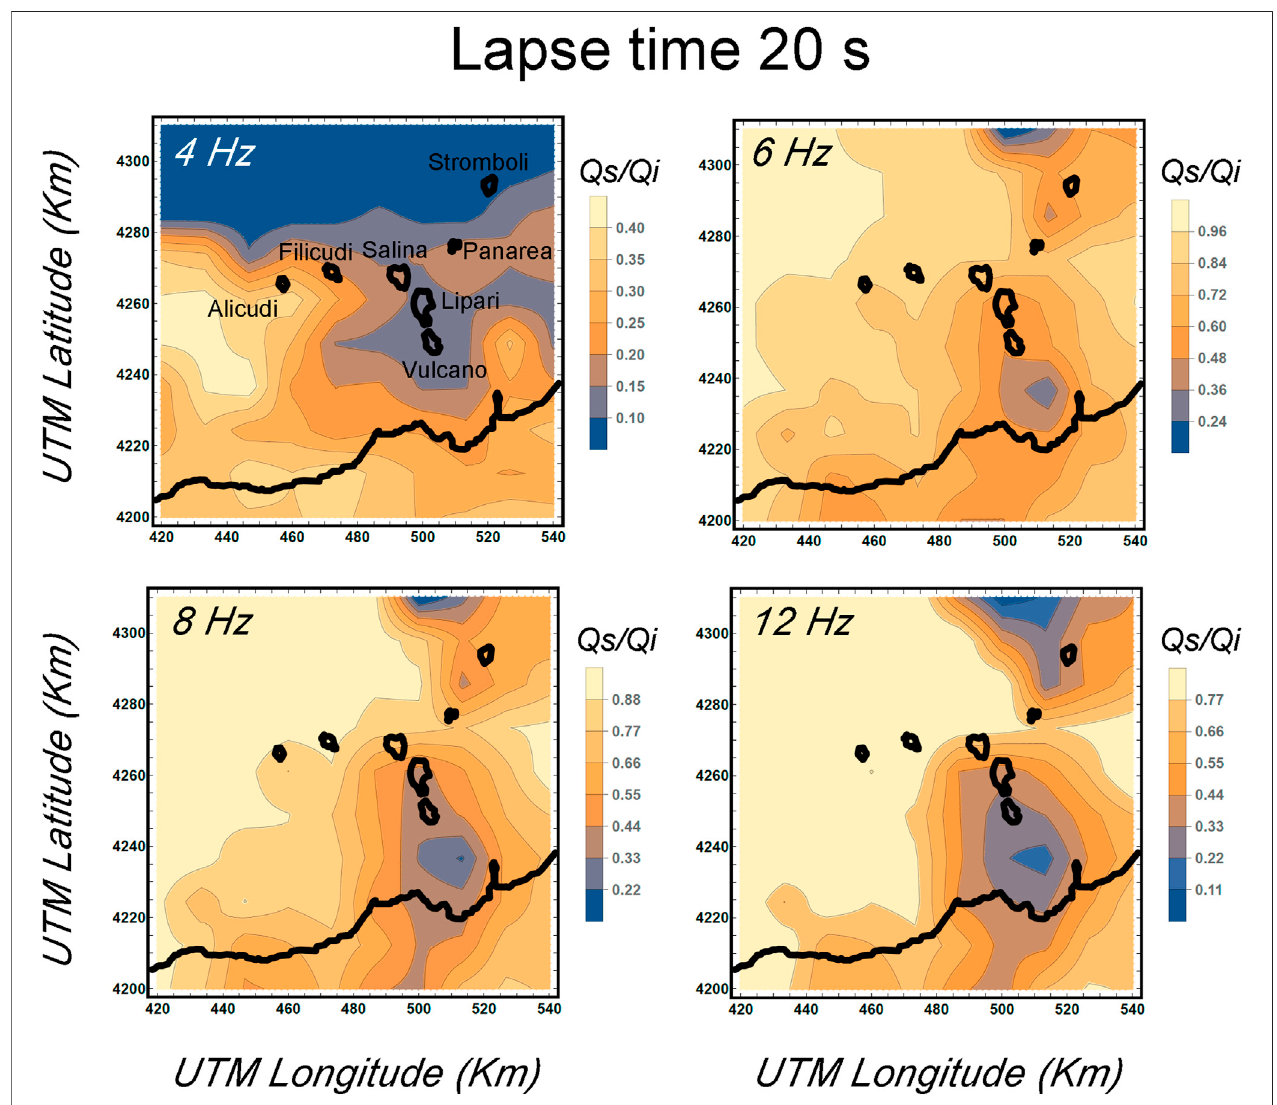
FIGURE 8 | Maps of Qs/Qi ratios for frequencies of 4, 6, 8, and 12 Hz with a lapse time of 20 s.